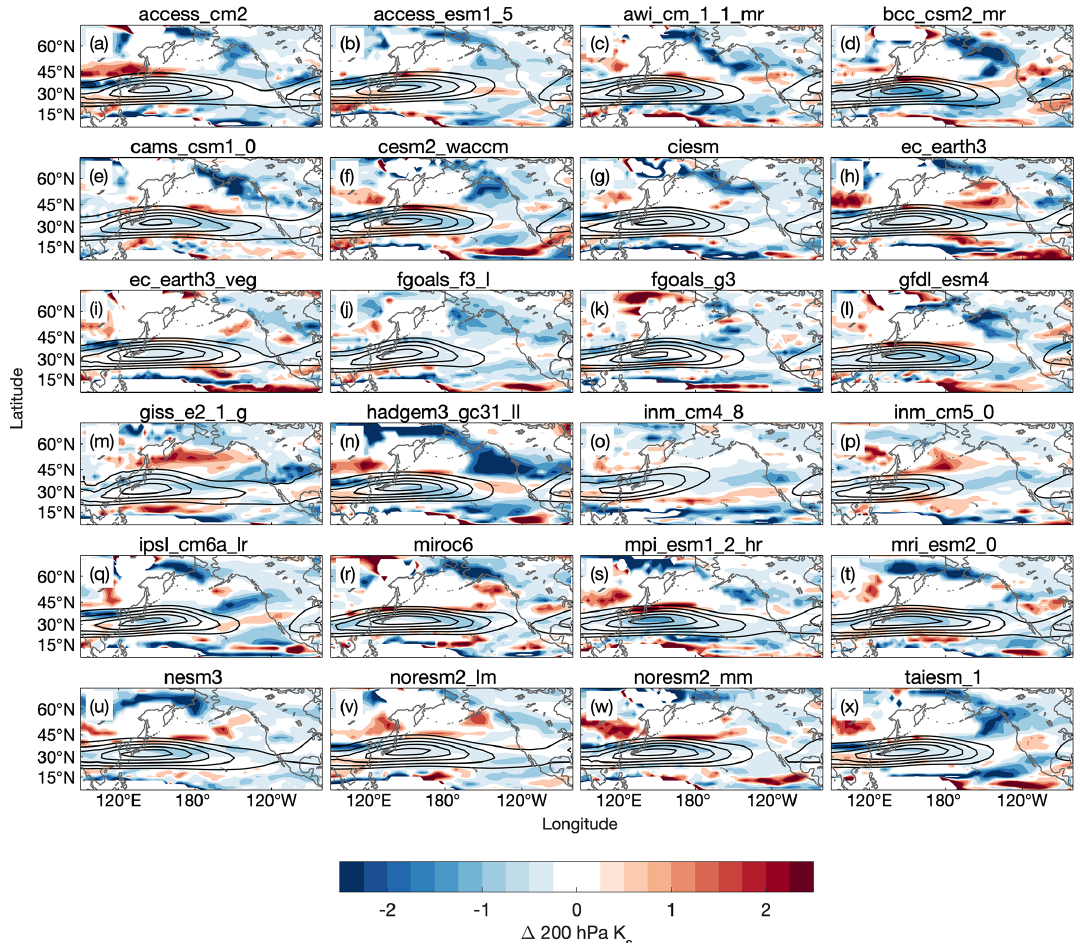
Figure A5. Shading is the difference in the January mean K s at 200hPa between the historical (1985–2014) and future periods (2071–2100) for models included in the analysis. Solid black contours show the January mean zonal wind at 200hPa, starting at 35ms − 1 and increasing by 10ms − 1